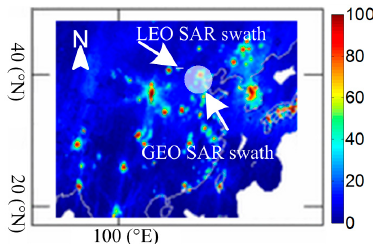
Figure 2. Comparisons between the GEO SAR swath and the LEO SAR swath and their covered RFI signals (SMOS RFI occurrence probability data in East Asia for 20170902 ± 7 days [31], red regions stand for the high probability of RFI occurrence).